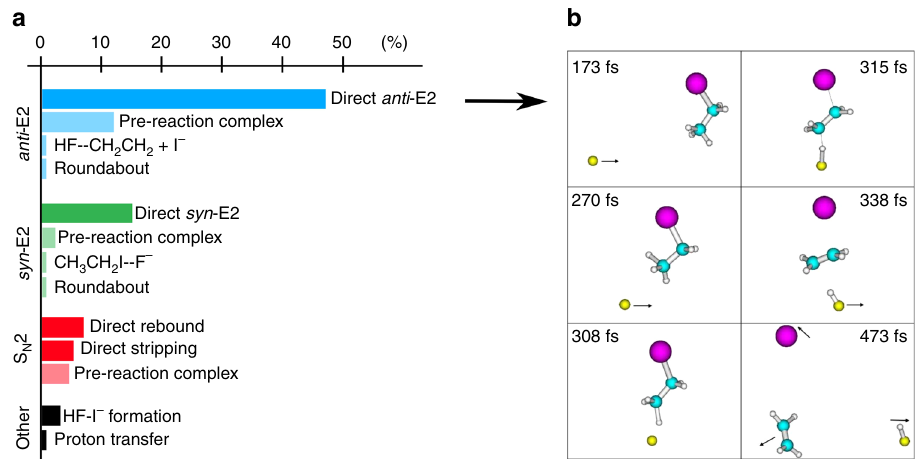
Fig. 4 a Branching ratio of the different mechanisms of S N 2 and E2 reactions in F − + C 2 H 5 I at 1.9 eV. Direct reaction pathways exhibit a dark colour, whereas all indirect mechanisms are marked by lighter colours. b Atomistic dynamics of a typical trajectory for the direct anti -E2 mechanism. The numbers indicated in the upper area of the cartoons correspond to the trajectory time in femtoseconds (10 − 15 s) 0.25